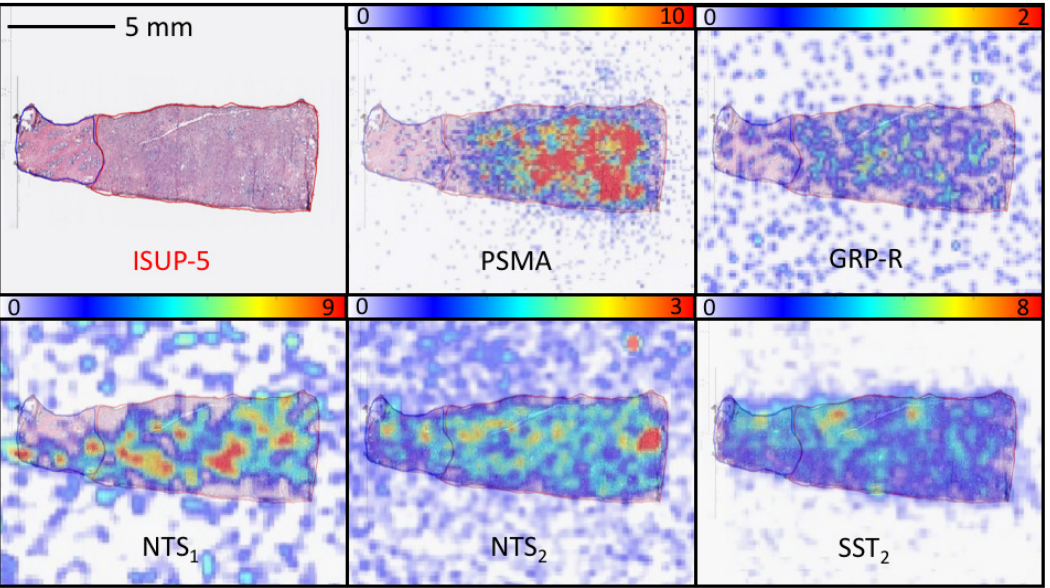
Figure 3. Comparison of the binding between PSMA, GRP-R, NTS 1 , NTS 2 and SST 2 -specific radio- pharmaceuticals on an ISUP-5 sample. The red line drawing on HES slice corresponds to the tumor area. Specific binding = 45% for PSMA, 40% for NTS 1 , 95% for NTS 2 and 40% for SST 2 . Specific binding was not available for GRP-R due to technical issues. Color scale refers to cps/mm 2 .